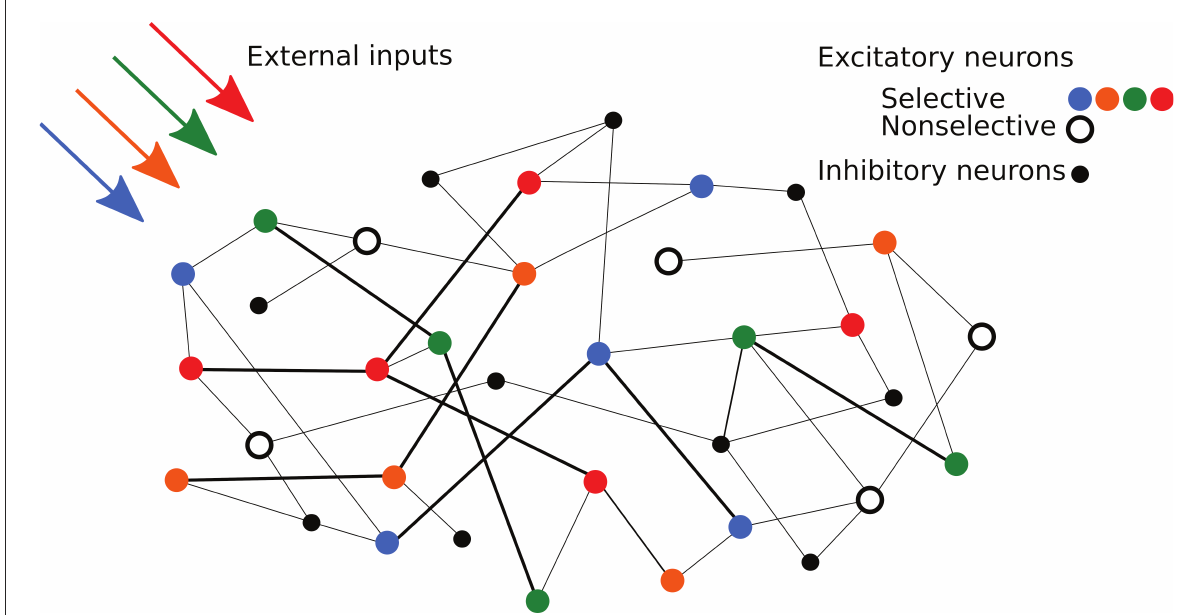
FIGURE1 Schematic representation of the network. Colored circles represent excitatory neurons of different selective populations, whereas the black open circles represent excitatory neurons of the non-selective population. Black circles represent inhibitory neurons. Strengthened connections are represented by thicker black